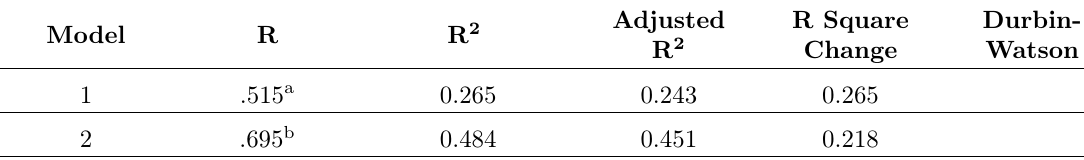
Table 4. Predictive model (stepwise regression) for GII improvement